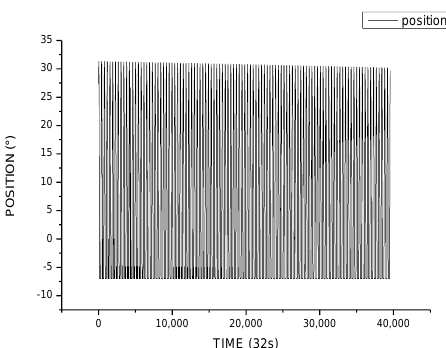
Figure 10. True position curve of pitch axis from data set.